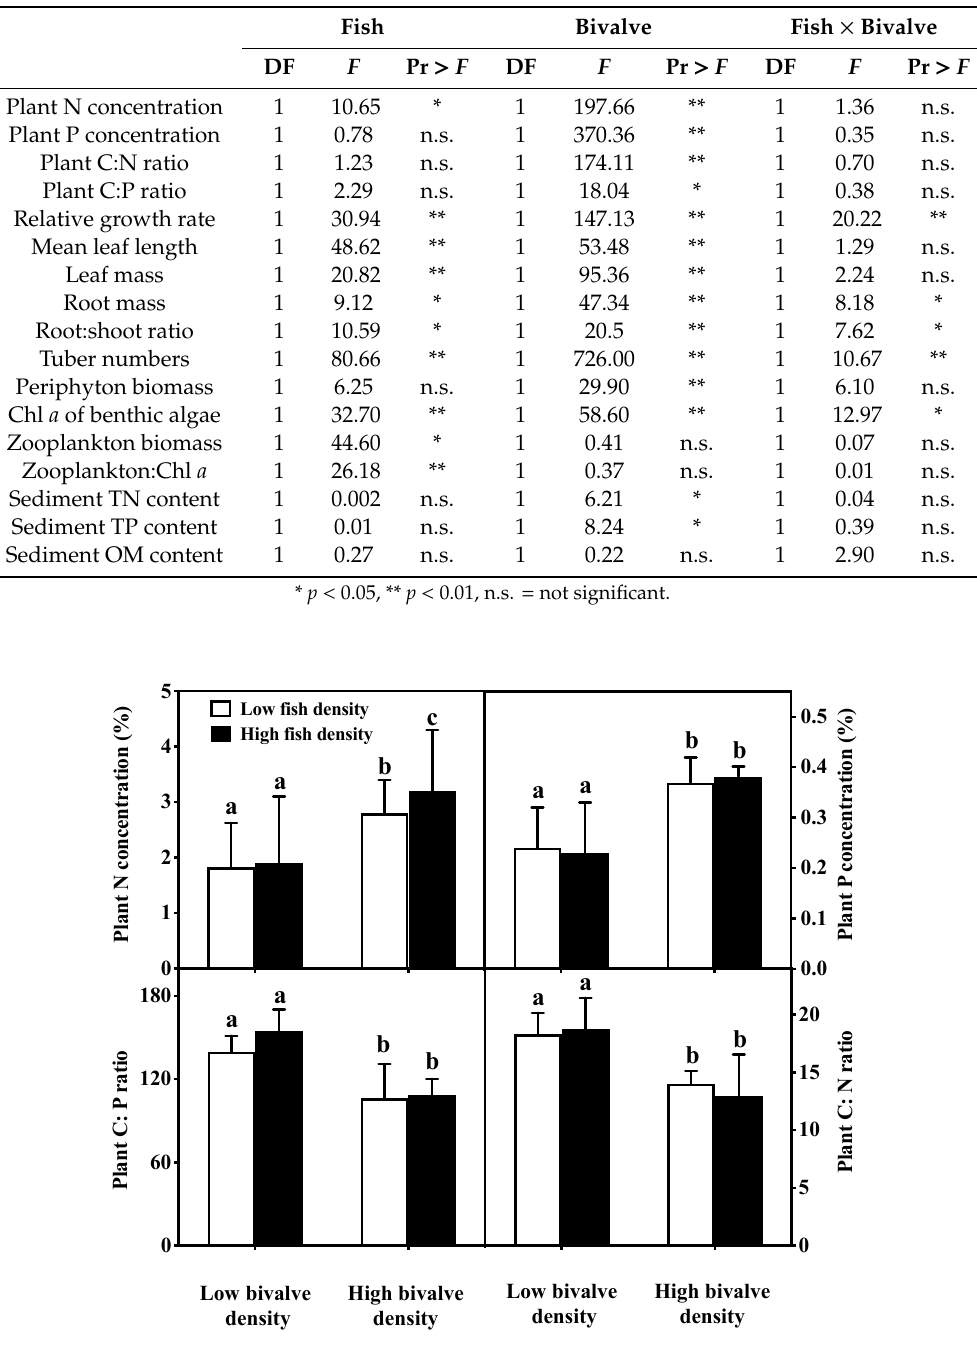
Table 2. Two-way analysis of variance (ANOVA) of plants and sediments characteristics, periphyton biomass, benthic algae, zooplankton abundances, zooplankton:Chl a at the end of the experiment. Fish Bivalve Fish × Bivalve DF F Pr > F Plant N concentration